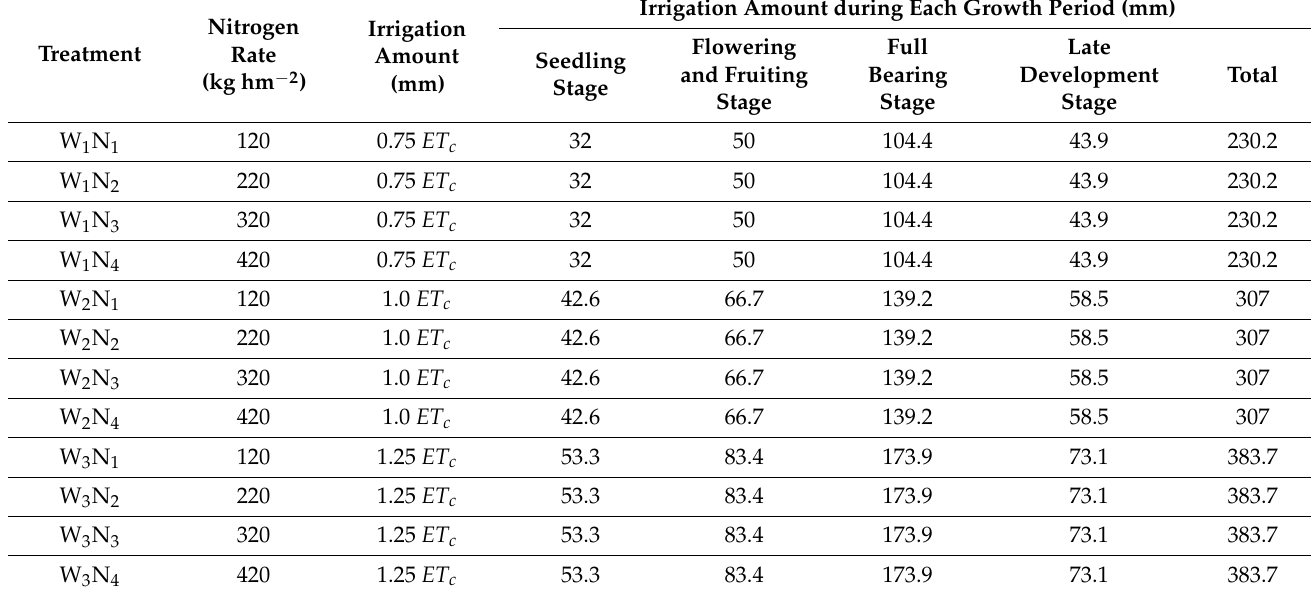
Table 2. Nitrogen application and irrigation amount in each growth